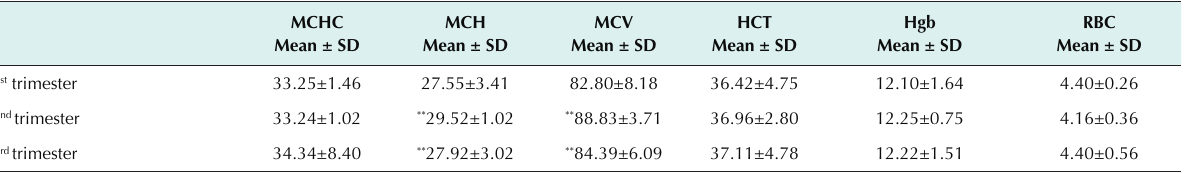
Table 4. Erythrogram in the 1 st , 2 nd , and 3 rd Trimester in a Normal